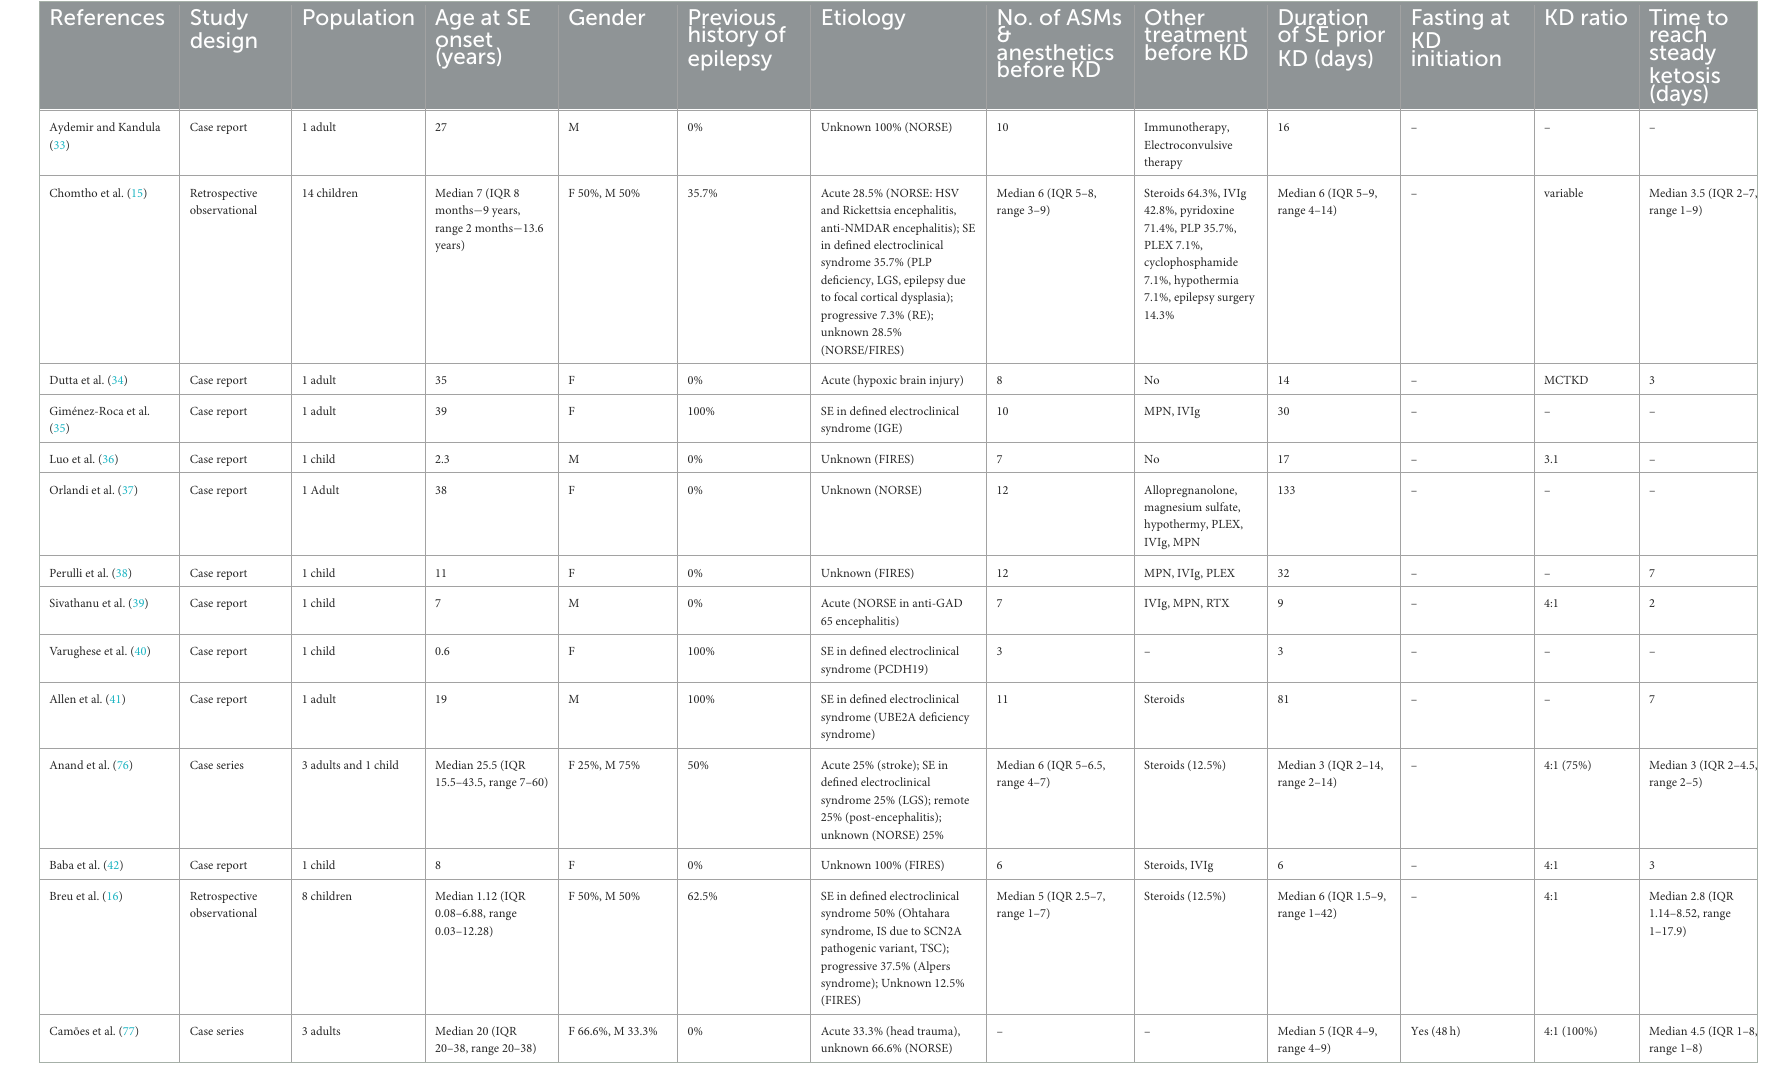
TABLE 3 Systematic review: summary of patients’ characteristics and KD